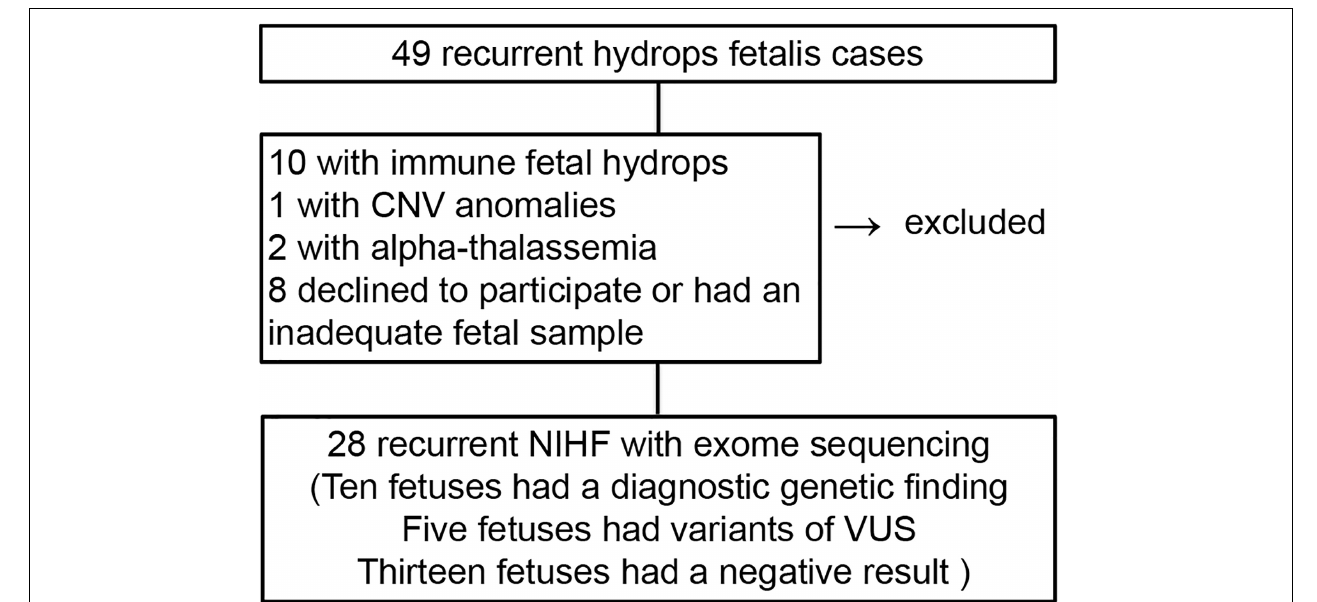
FIGURE 1 | The flow diagram of the cohort and